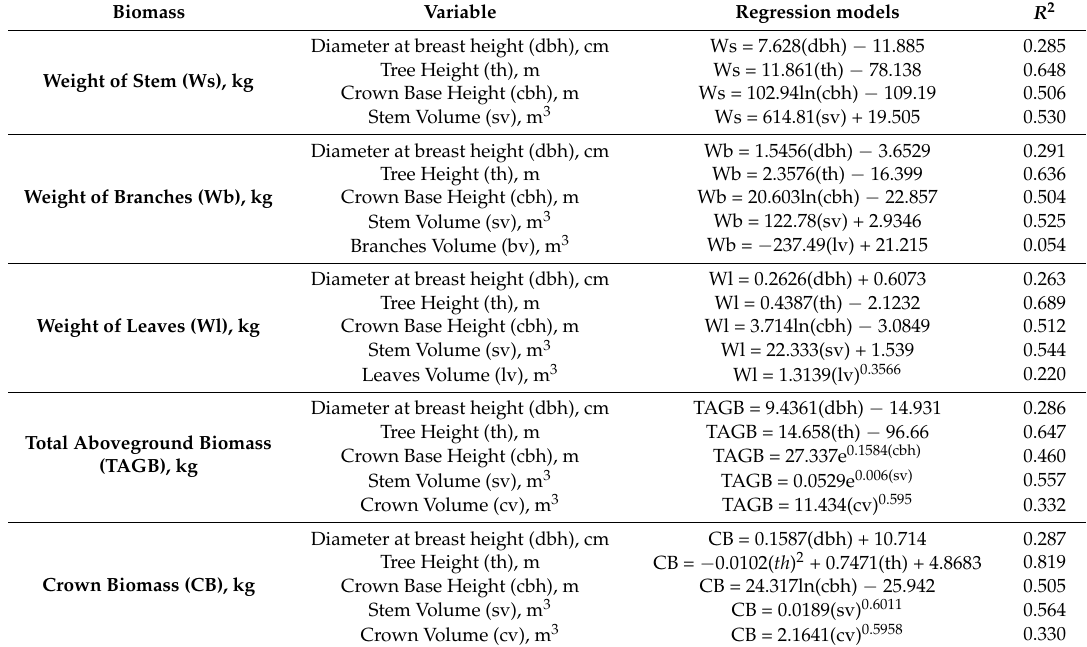
Table A4. Allometric equation generated for Kelat with tree variables obtained from TLS.